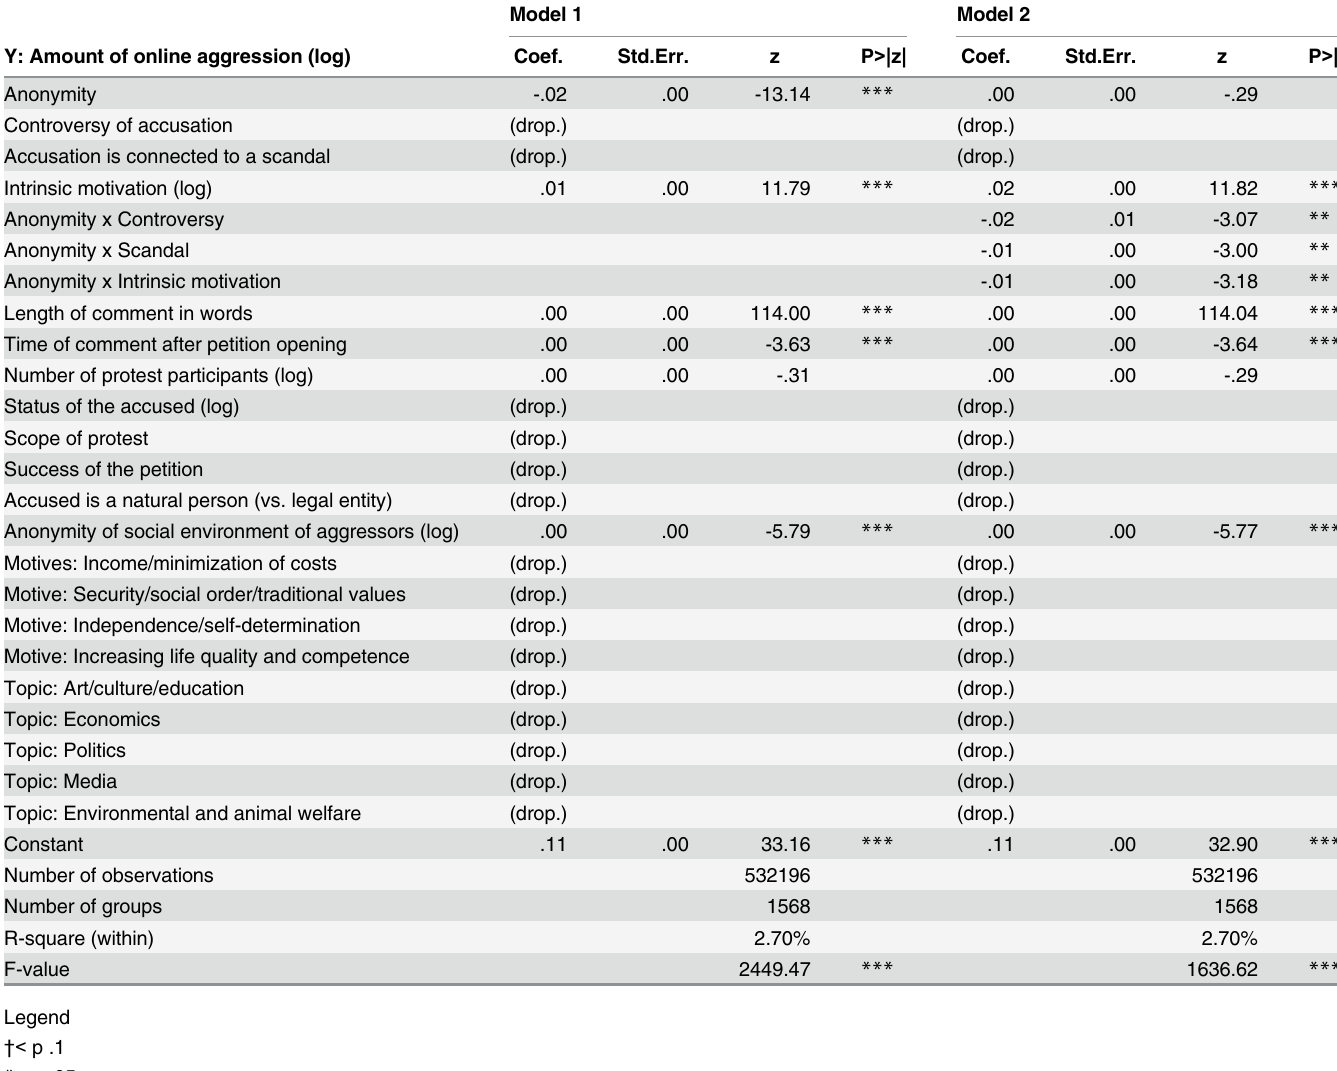
Table 2. Predicted amount of online aggression dependent on the anonymity of aggressors (fixed-effects